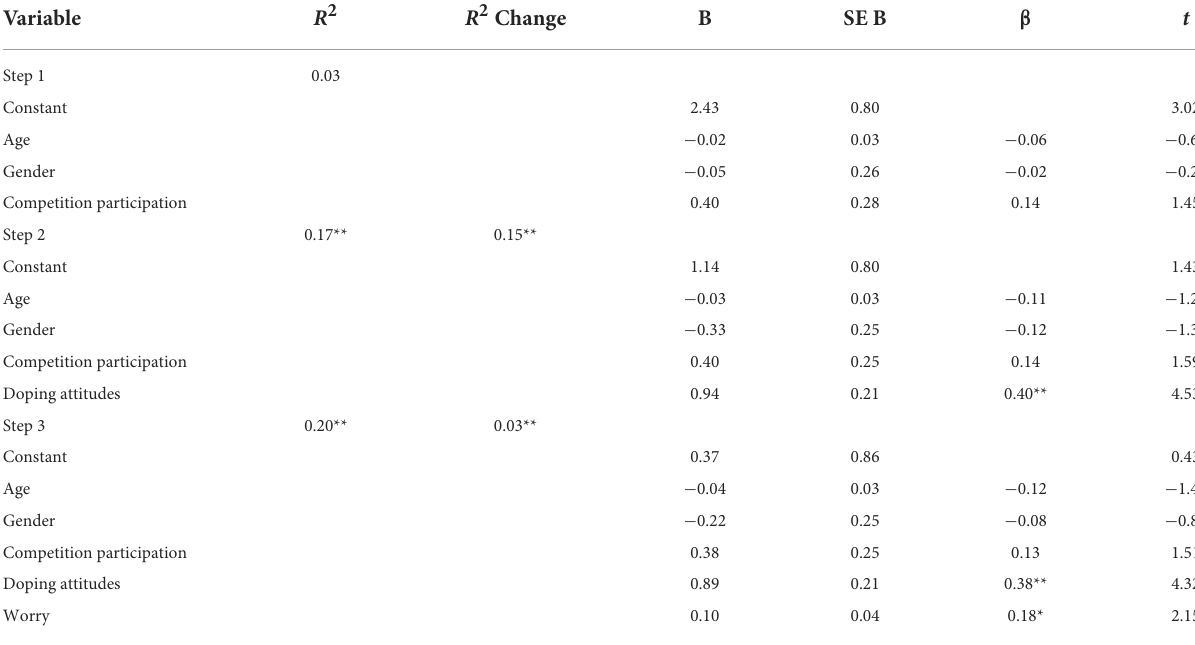
TABLE 4 Hierarchical regression model of analgesic misuse in an unfavorable